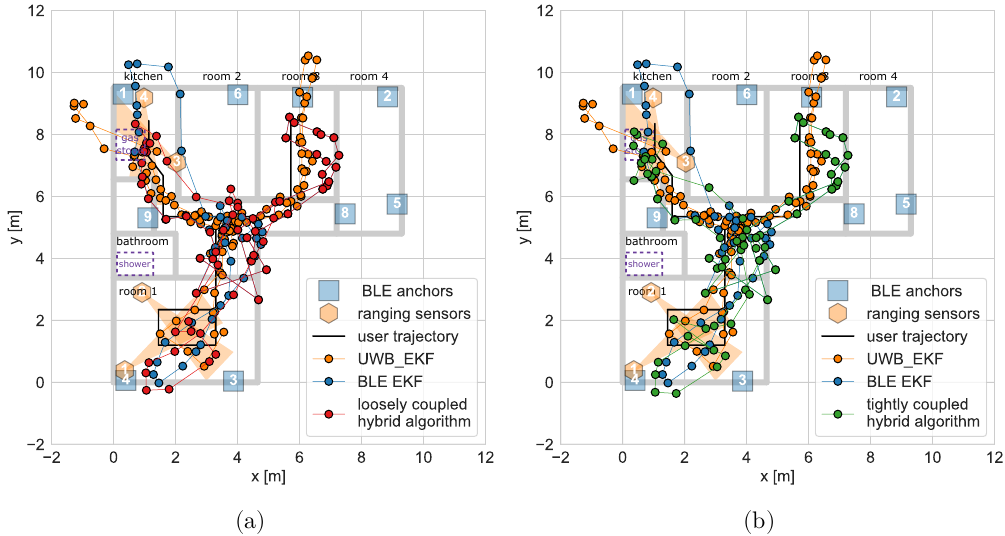
Figure 12. Experiment results obtained for test path 1 using: ( a ) loosely coupled hybrid algorithm, ( b ) tightly coupled hybrid algorithm with BLE-based localization results as reference.